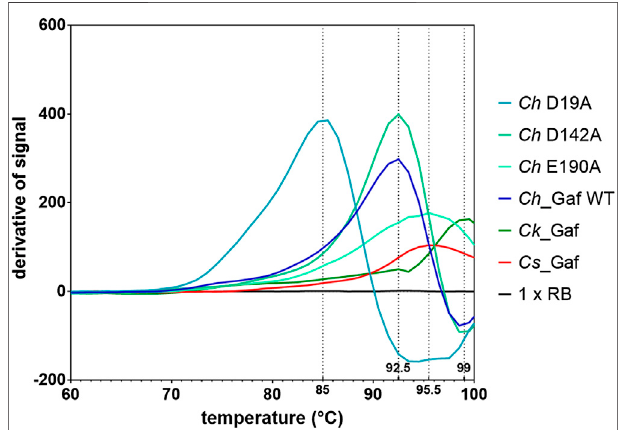
FIGURE 6 | Melting temperatures of Cs _Gaf159A, Ck _Gaf159A, Ch _Gaf159A and the mutants Ch _D19A, Ch _D142A and Ch _E190A according to differential scanning fl uorimetry analysis with SYPRO Orange. Smoothed differentiated curves from triplicates.